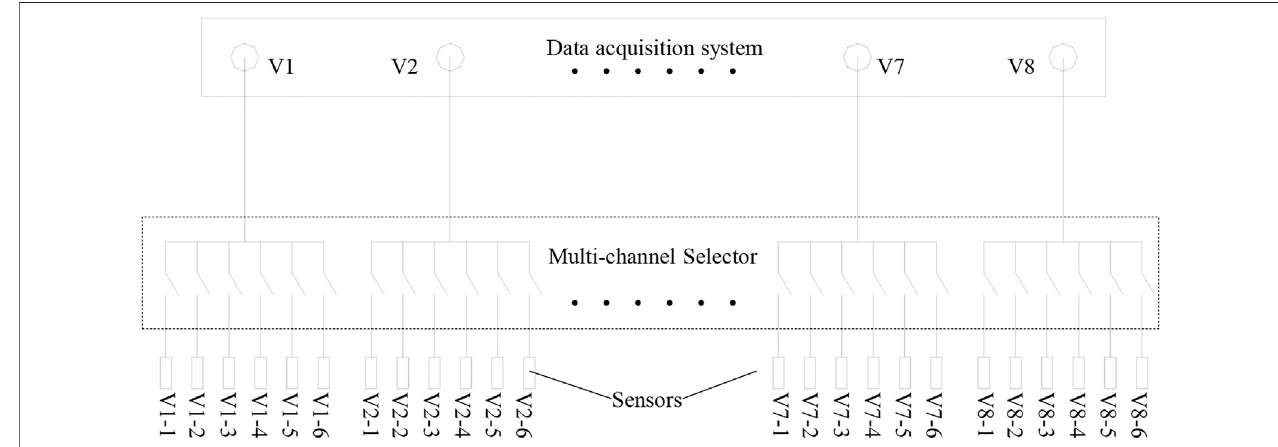
FIGURE 3 | Multi-channel selector connection diagram.